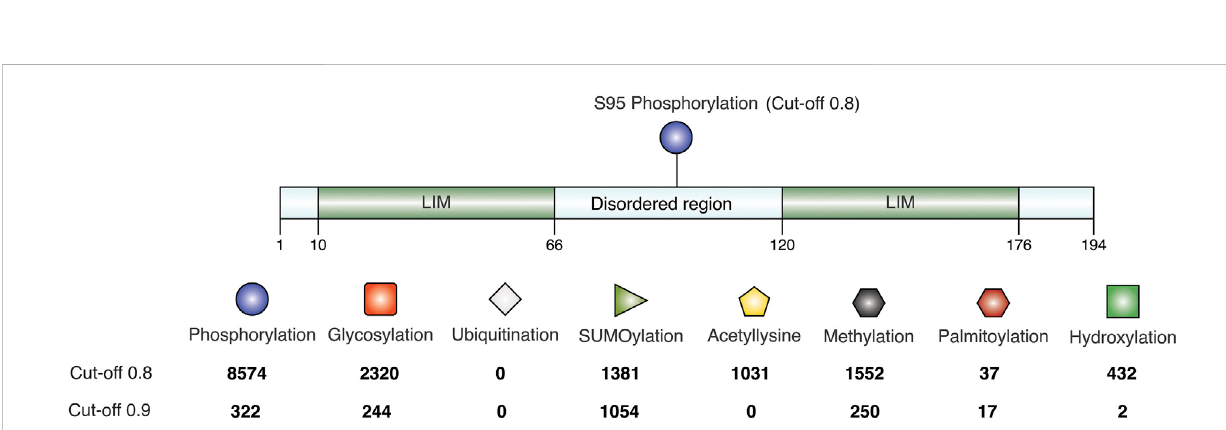
FIGURE 6 Post-translational modi fi cations in the disordered region. The frequency is calculated at score of 0.8 and 0.9 predicted by MusiteDeep. PTMs like phosphorylation, glycosylation, ubiquitination, SUMOylation, acetylation, methylation, palmitoylation, and hydroxylation are